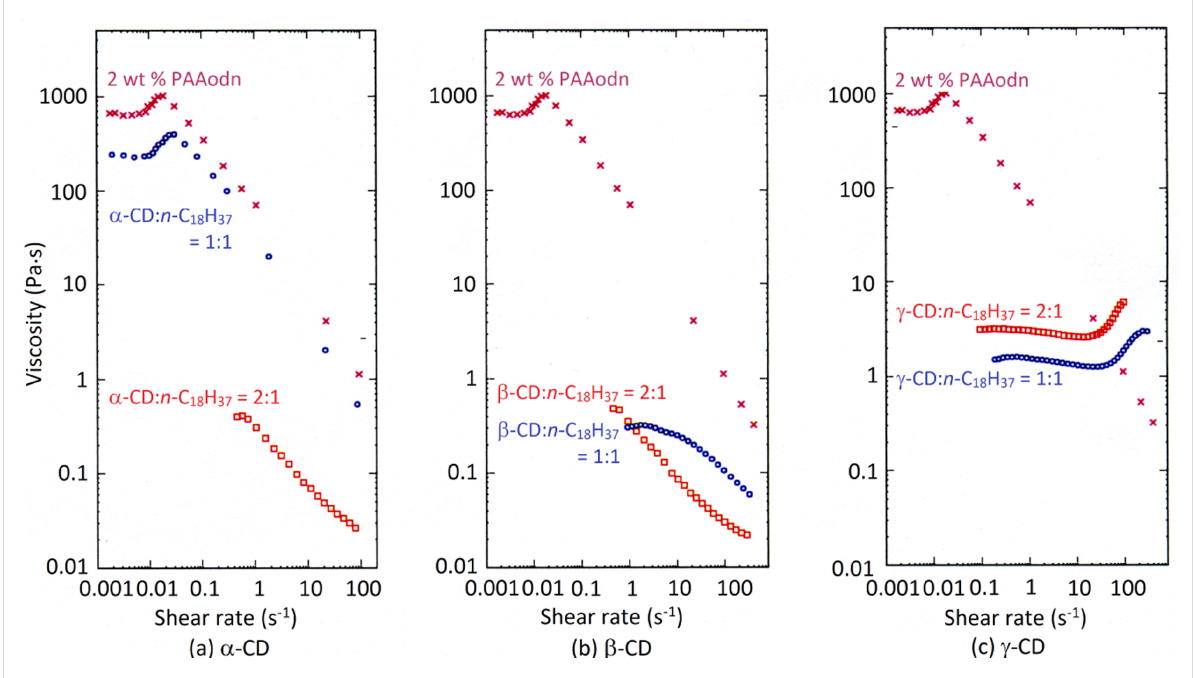
Figure 4: The effect of (a) α -CD, (b) β -CD and (c) γ -CD on the hydrophobic interactions between n -C 18 H 37 substituents of 2% randomly substituted poly(acrylate), PAAodn, in 2 wt % aqueous solution (0.10 M NaCl, pH 7.0) as indicated by shear rate. The data sets refer to 2 wt % PAAodn alone (crosses), and where cyclodextrin to n -C 18 H 37 substituent mole ratios are: 1:1 (circles) and 2:1 (rectangles). Adapted with permission from [46]. Copy- right (2008) American Chemical